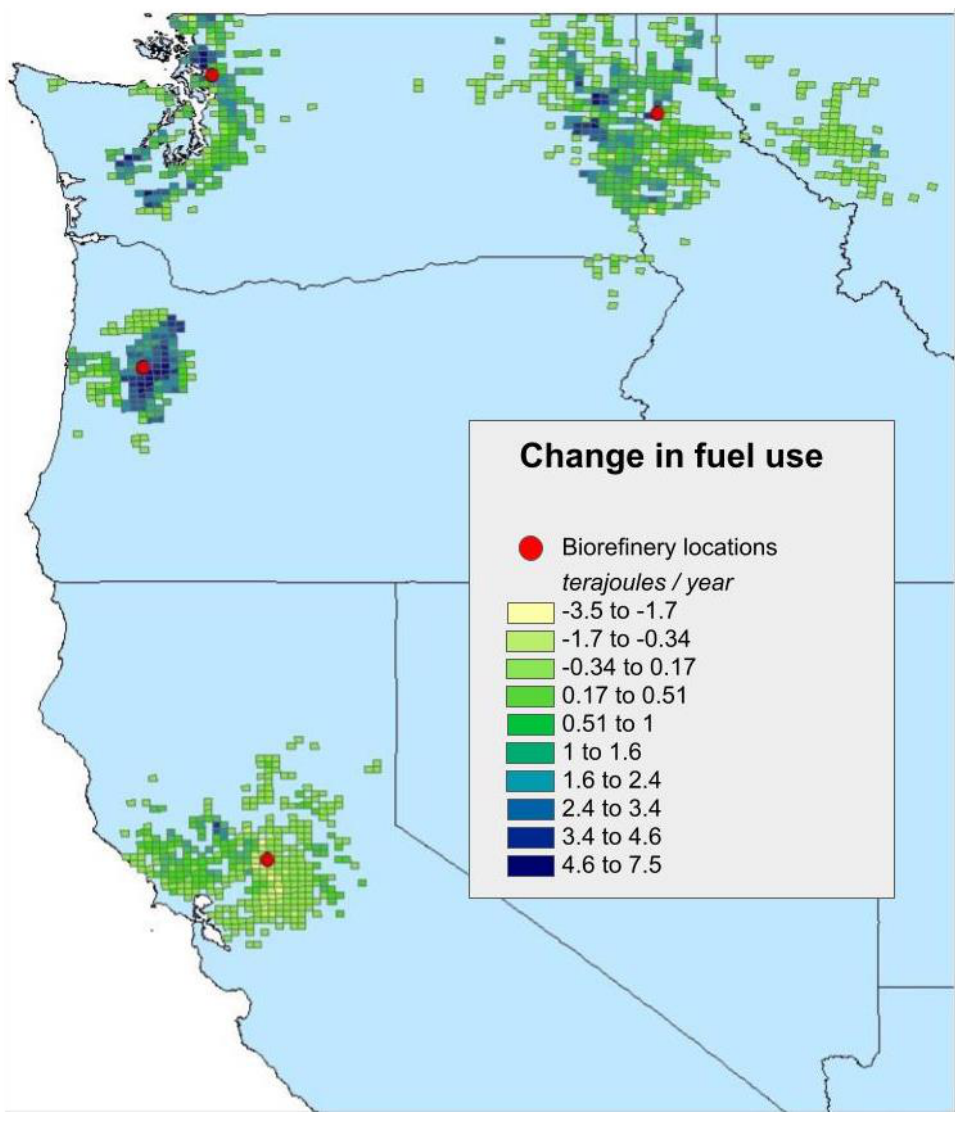
Figure 6. Change in fuel use for each pixel as a result of switching from current practices to growing poplar trees for bio-jet fuel production. Fuel use includes diesel and gasoline. Green to yellow indicates a decrease in fuel use when switching to poplar. Light blue to dark blue indicates an increase in fuel use. Table 9. Poplar chip transportation. Farm gate to biorefinery gate. Distances listed here are one-way. Round trip distances are used for assessing fuel use as part of life cycle